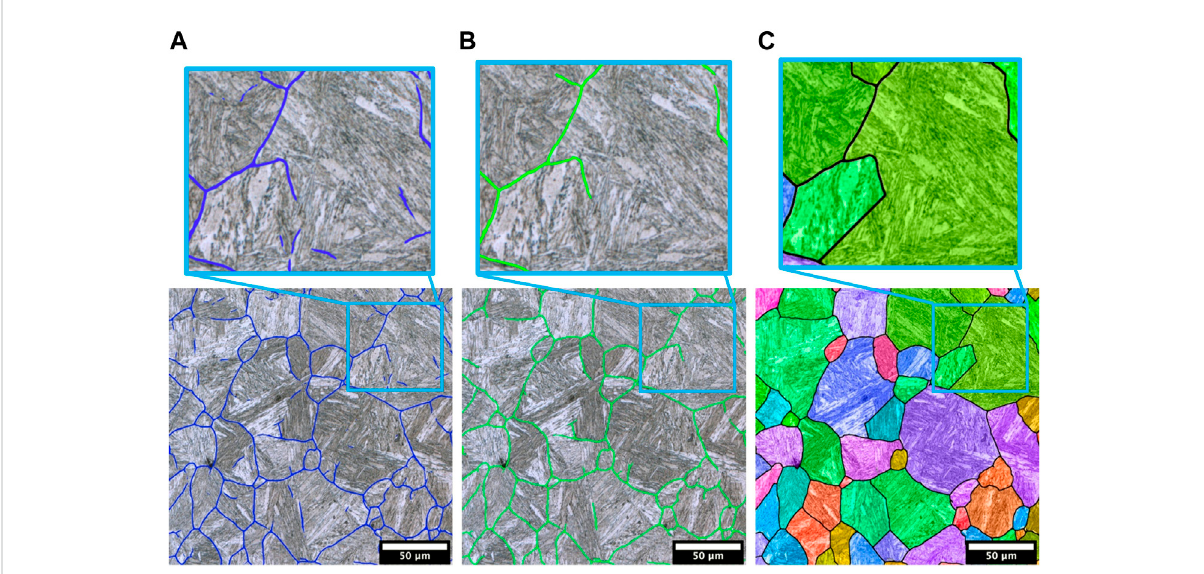
FIGURE 5 (A) :LOMofsampleB(coolingrateof2,400 ° C/s)withoverlayedsegmentationresult(blue) (B) :LOMwithsegmentationresultafterareaopening step (green). (C) : LOM micrograph with reconstructed PAGB (black) and colored PAG labels after watershed